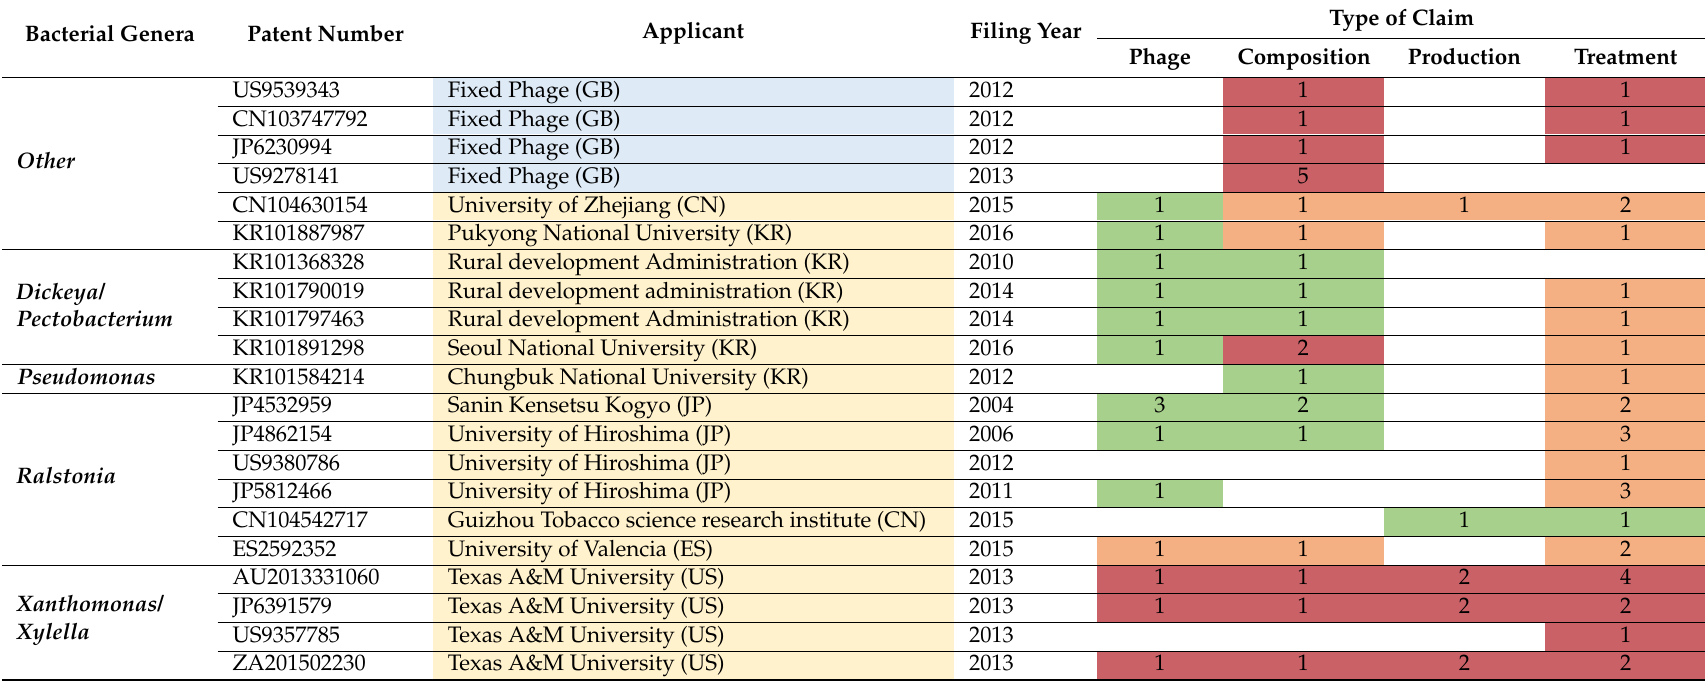
Table 1. Claim analysis of the granted patents. Within this table, all granted patents have been organized according to the bacterial genera they describe, their patent number, the applicant (private sector in blue and public sector in yellow) and the nationality of the applicant (CN China, ES Spain, GB United Kingdom, JP Japan, KR Korea, and US United States), and the filing year. Moreover, the claims were categorized according the four different categories: (1) Phage: claims protecting one or multiple phages and their genome sequence, (2) Composition: claims discussing the composition of a phage product, (3) Production: methods to produce phages, and (4) Treatment: methods to use phages as a treatment for plant diseases. If a patent contains claims that belong to a specific category, it is quantified. The colors indicate the scope of a claim or set of claims: very narrow, intermediate, or broadly-defined (green, orange, and red,